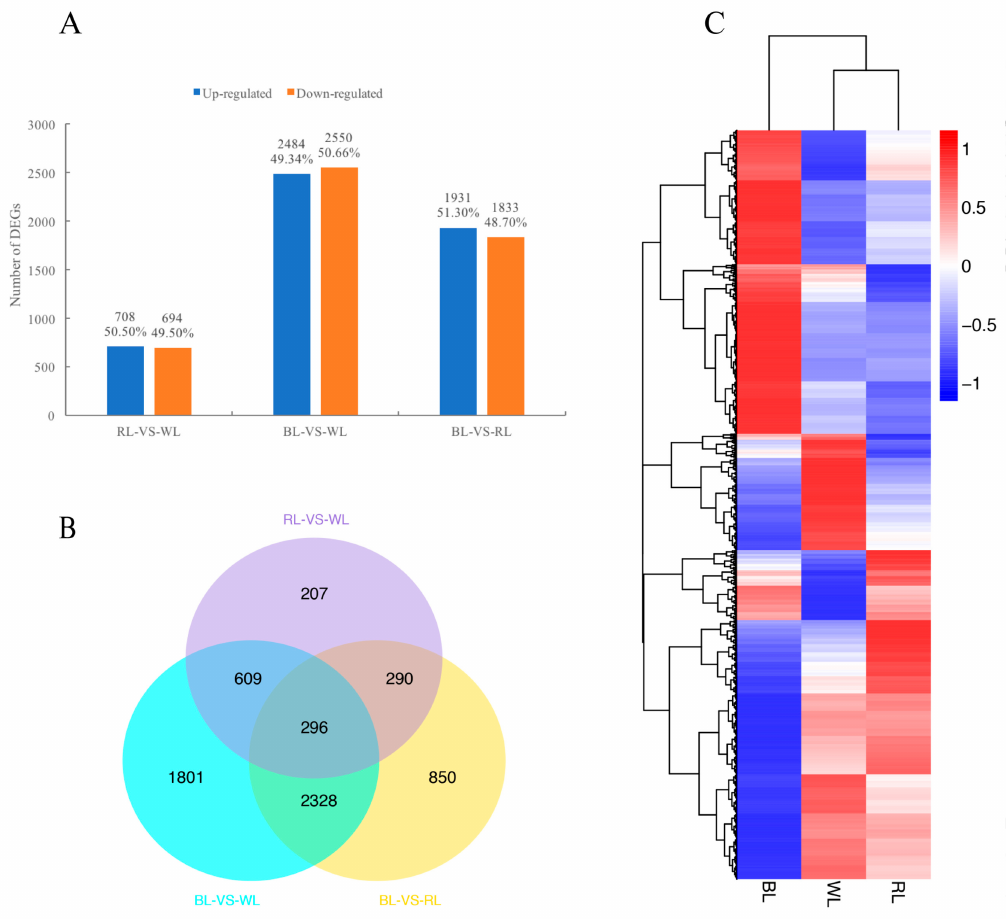
Figure 2. Differential gene expression in response to light quality. ( A ) Numbers of DEGs in pairwise comparisons of the three libraries; ( B ) Venn diagram showing DEG distributions; and ( C ) expression profile clustering. The color scale at the right represents re-processed log10 (FPKM+1) using Pheatmap, representing the relative expression level. The expression variance for each gene is indicated by different colors ranging from low (blue) to high (red). WL, RL, and BL indicates samples treated by white light, red light, and blue light,